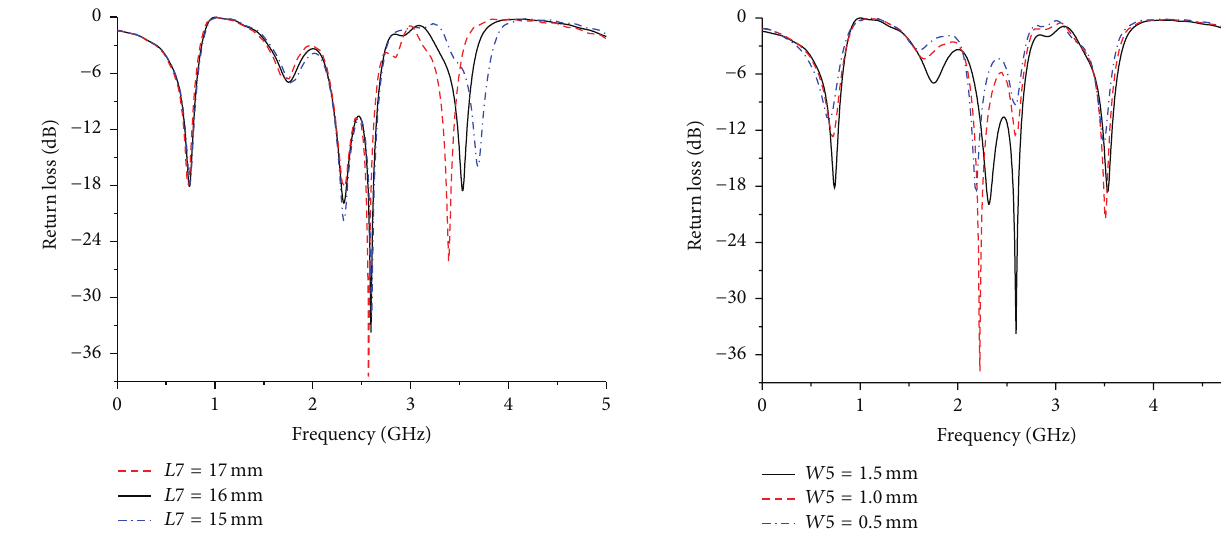
Figure 6: Simulated return loss characteristics for the proposed antenna for various values of 𝑊5 .